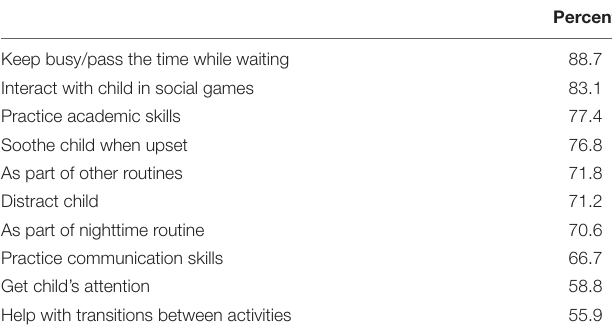
TABLE 3 | Percent of parents that endorsed using music with their child for each